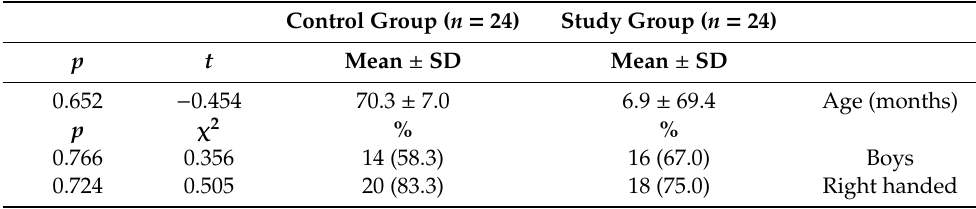
Table 1. Demographic characteristics of the study group (children who were referred to a child developmental center due to various motor di ffi culties) and control group. Data are presented as either mean and standard deviation (SD) or number and percent of the study group populations. Control Group ( n = 24) Study Group ( n =